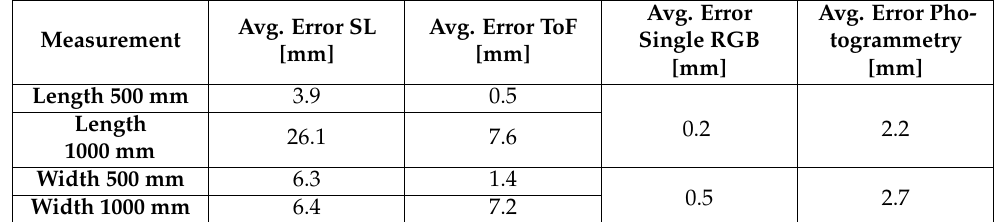
Table 2. Comparison of the measurement